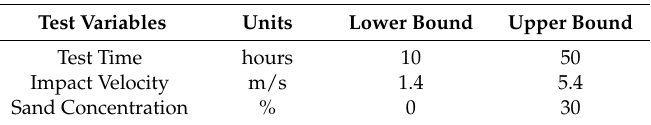
Table 2. Lower and upper bounds for the test variables.